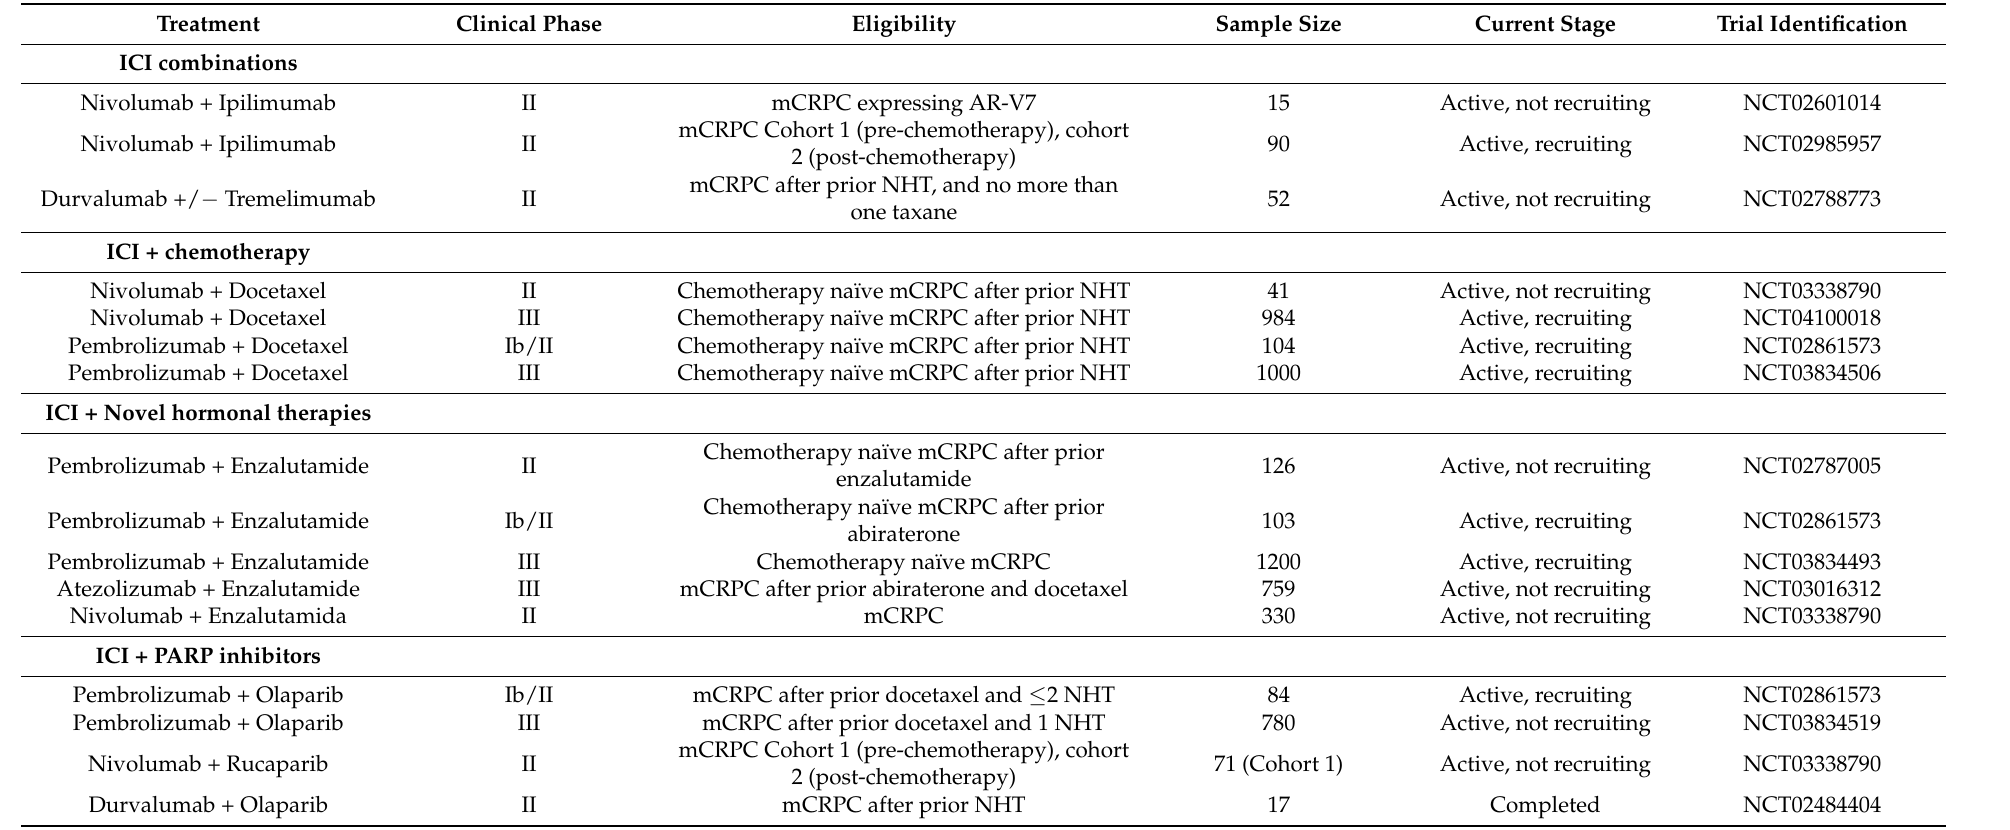
Table 1. Selected clinical trials of ICI in combination with prostate cancer